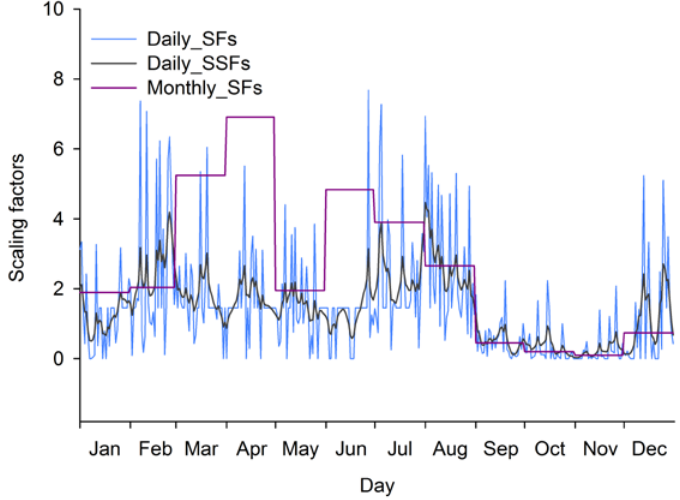
Figure 4. Scaling factors calculated by the PELS method (blue line without smoothing and black line with smoothing ) and original linear scaling (red line) at Jhelum site for 1971‒1985 period .